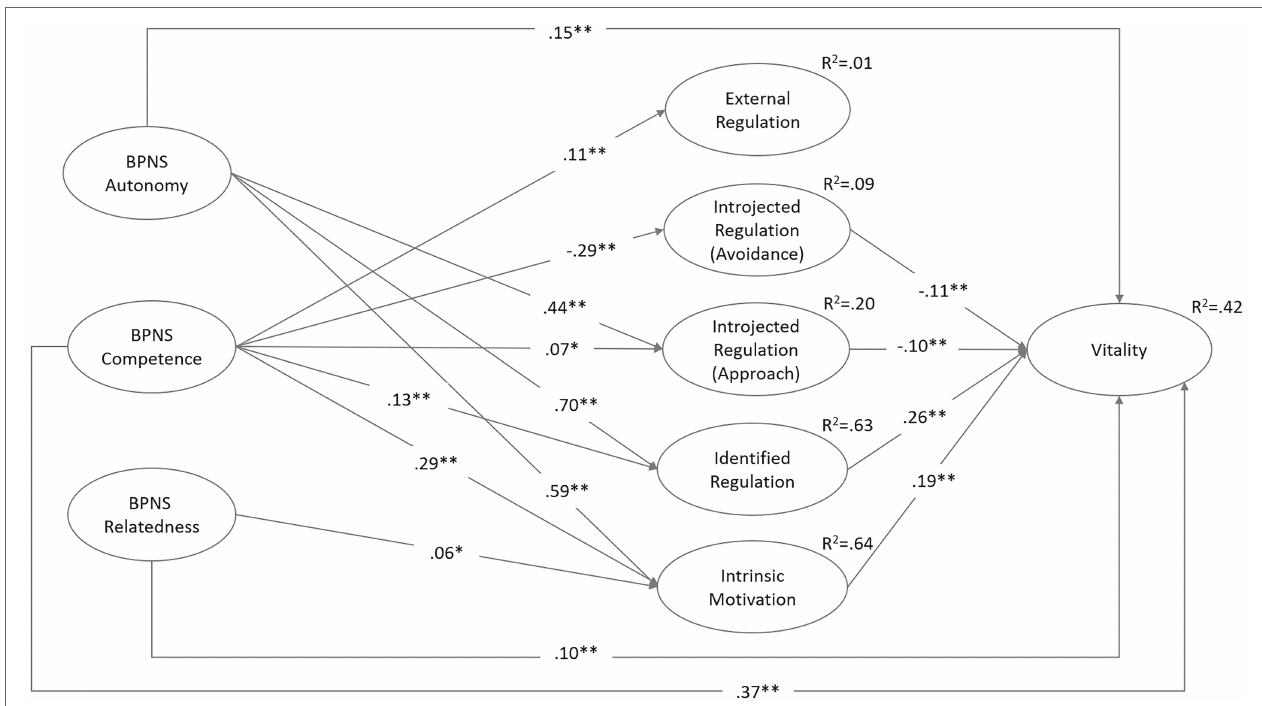
FIGURE 1 | Structural equation model with BPN-Satisfaction, motivational regulation, and vitality (during the forced distance learning period). χ 2 (488) = 1667.328, p < 0.01, CFI = 0.965, RMSEA = 0.026. Variables are modelled latently; measurement models are not shown; * p < 0.05, ** p < 0.01; non-significant paths are not shown. A model in which social relatedness was differentiated according to peers and faculty did not yield any additional explanatory value for motivational regulation and vitality. In addition, the fit indices were slightly worse [ χ 2 (360) = 1440.024, p < 0.01, CFI = 0.959, RMSEA =